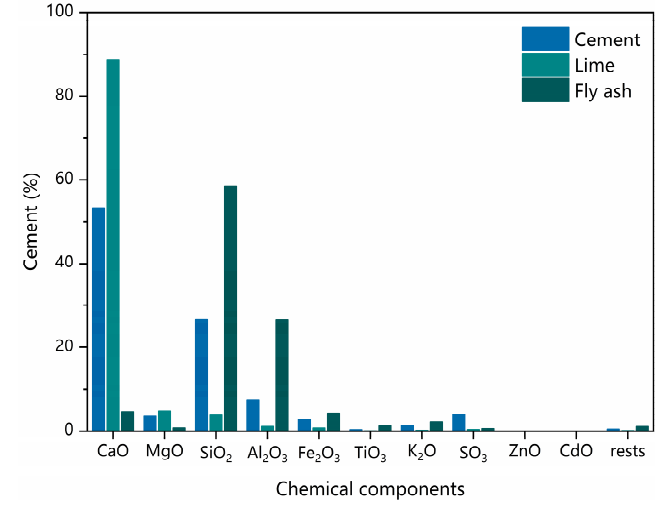
Figure 2. The chemical components of three binders.